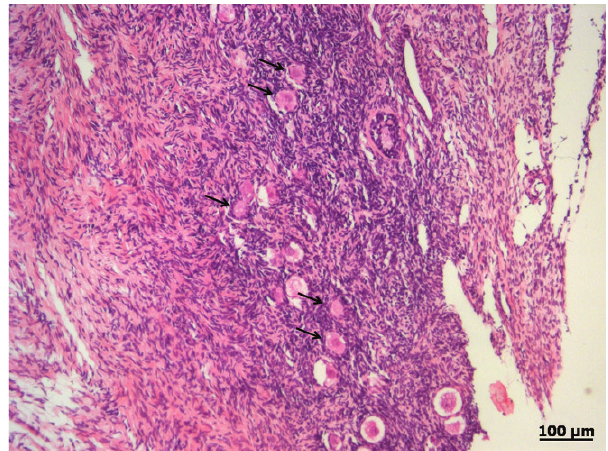
Figure 2 - A histological section of cryopreserved ovarian tissue, stained with H&E for the assessment of follicular density. The arrows indicate primordial and